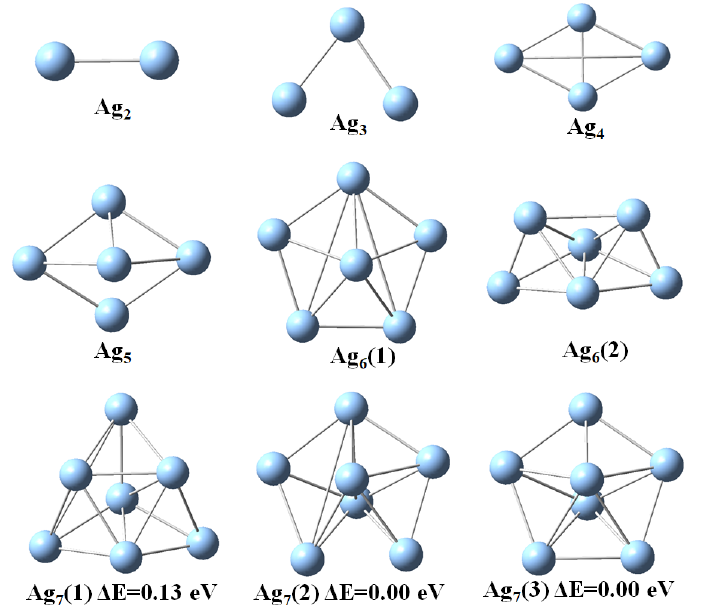
Figure 1. Optimized geometries of of Ag n ( n = 2–7) clusters as obtained with the DFT calculations. The labels refer to the energetic ordering according to the EAM